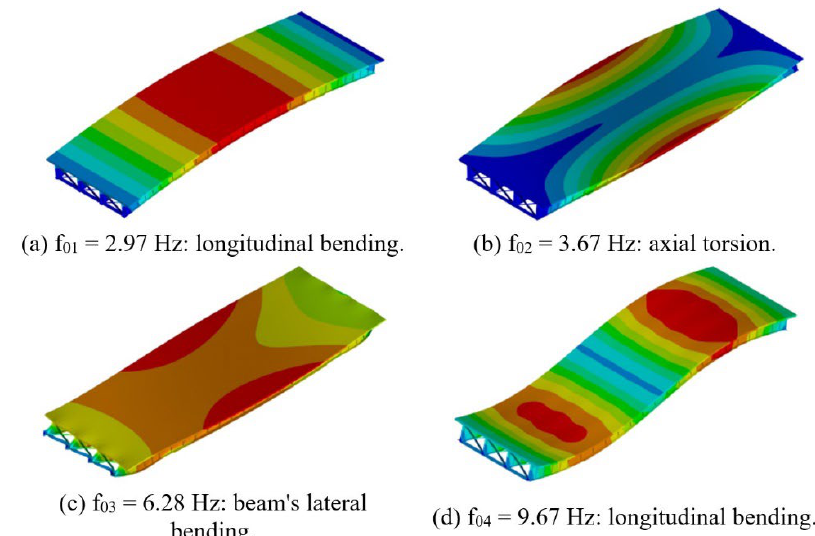
Figure 7. Investigated bridge global vibration